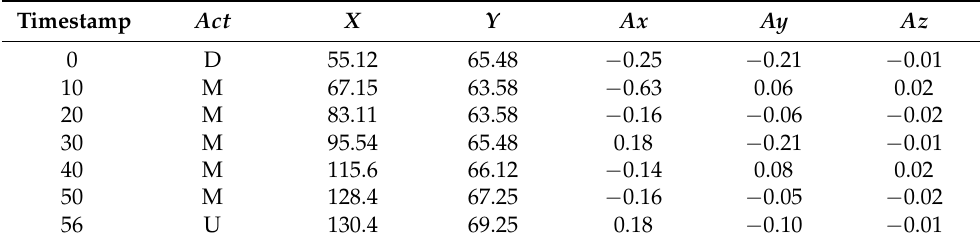
Figure 3. Example of data collection ( TS denotes timestamp). Table 4. Sample of the collected raw